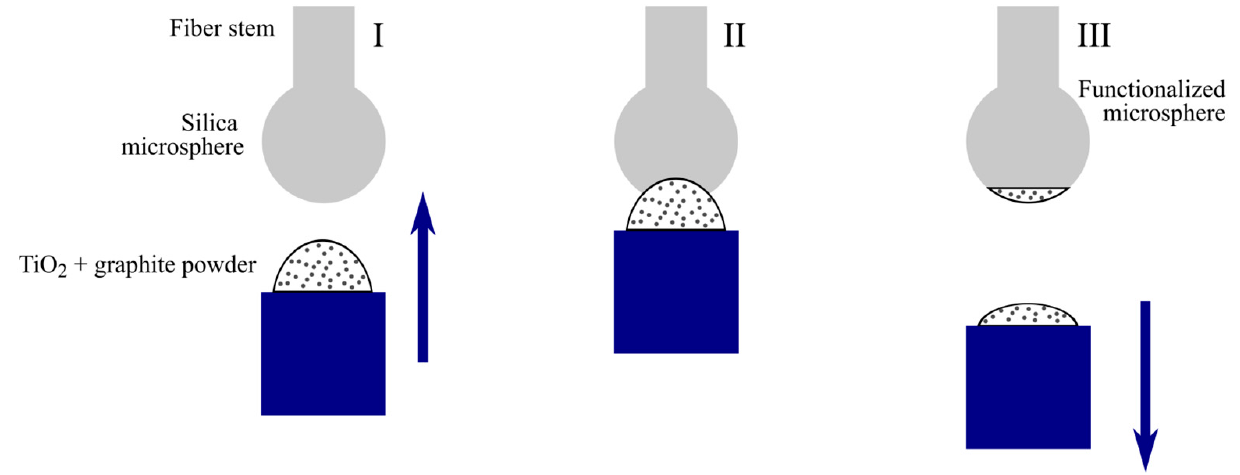
Figure 1. Process of microsphere coating with TiO 2 mixed with graphite powder.